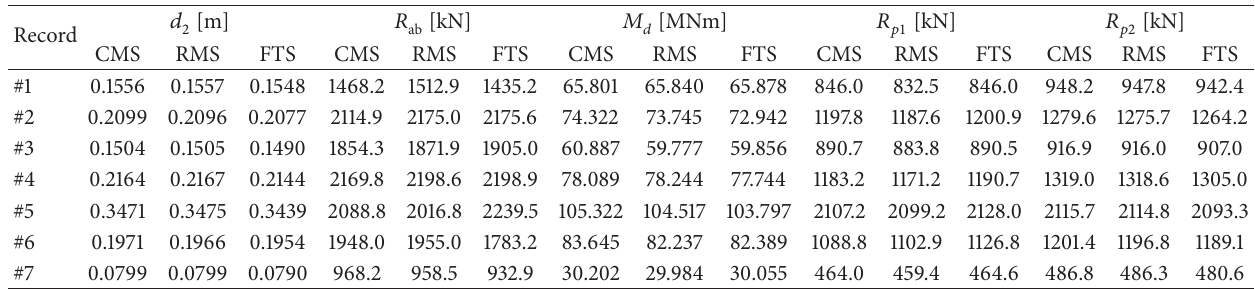
Figure 11: Transverse displacements 𝑢 max (a) and bending moments 𝑀 𝑑, max (b) along the deck according to the exact and the simplified analysis techniques. Table 4: Comparison of results according to the different analysis techniques for each of the 7 ground motion records considered.